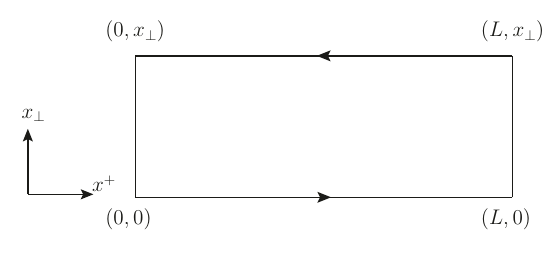
Figure 1 . Wilson loop W ( x ⊥ , L ) leading to